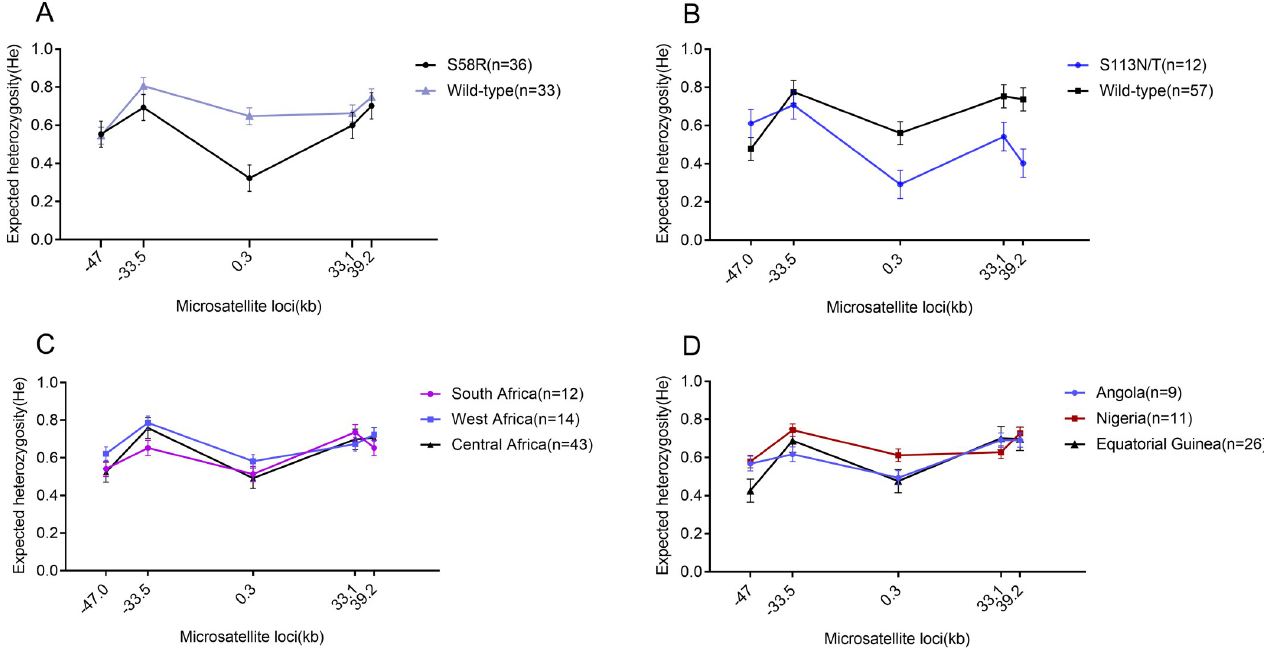
Fig 3. The expected heterozygosity (H ) of microsatellite loci flanking podhfr gene in P . ovale curtisi . (A) S58R mutant strains vs wild-type strains. (B) e S113N/T mutant strains vs wild-type strains. (C) Comparison in different regions in Africa. (D) Comparison in different countries in Africa.